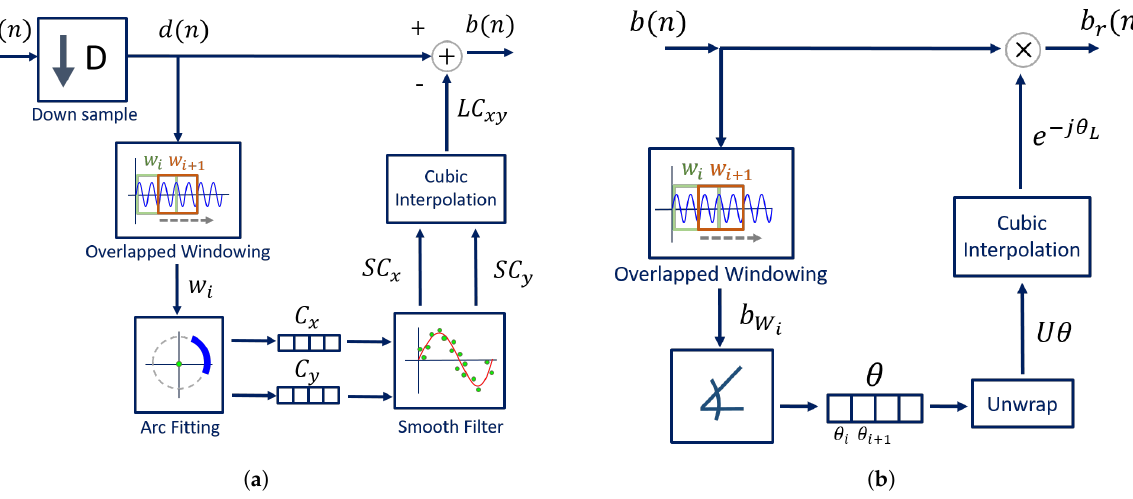
Figure 10. DSP dynamical implementation: ( a ) Dynamic CDC removal, ( b ) Dynamic arc